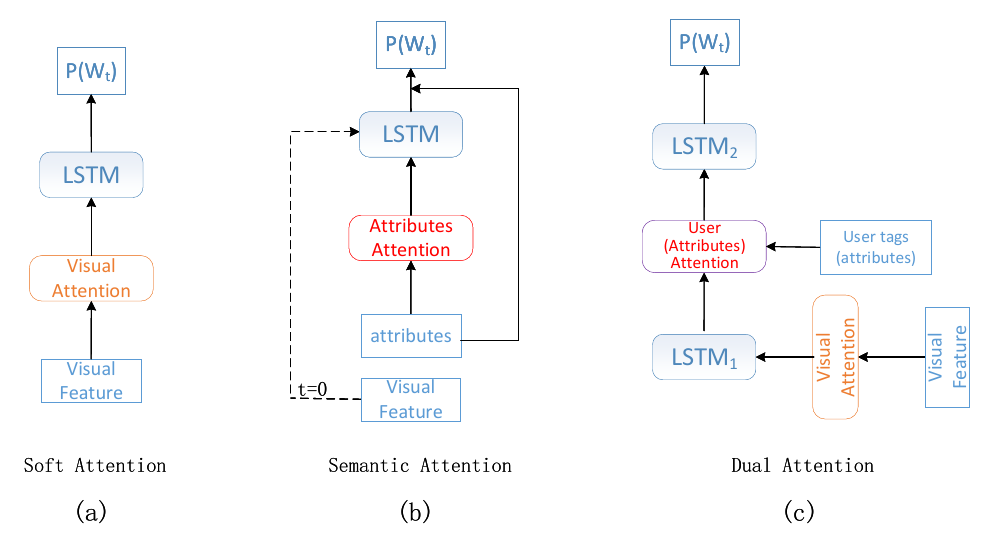
Figure 2. Comparisons with soft visual attention, semantic attention and proposed dual attention image captioning schemes. For the ease of comparisons, the role of user attention in the dual attention model can be regarded as attribute attention. ( a ) Only visual features are used to generate image captions in soft attention. ( b ) Attributes and visual features are used to generate image captions in semantic attention. However, visual features are used only at the first time step. ( c ) Both tags (attributes) and visual features are used to generate image captions in dual attention at every time